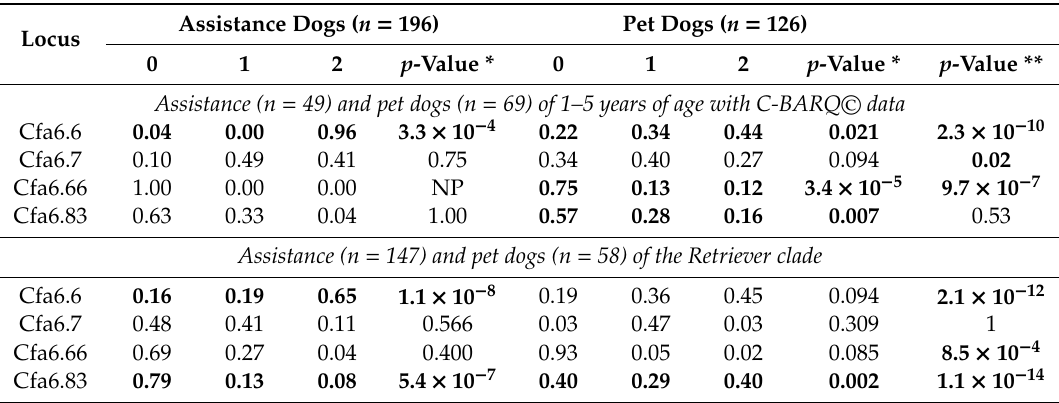
* p -value derived from Hardy–Weinberg equilibrium exact tests, assessing within-group allele frequencies against the HWE null hypothesis; ** p -value derived from Fisher’s exact test, assessing di ff erences in allele frequencies between assistance and pet dogs.